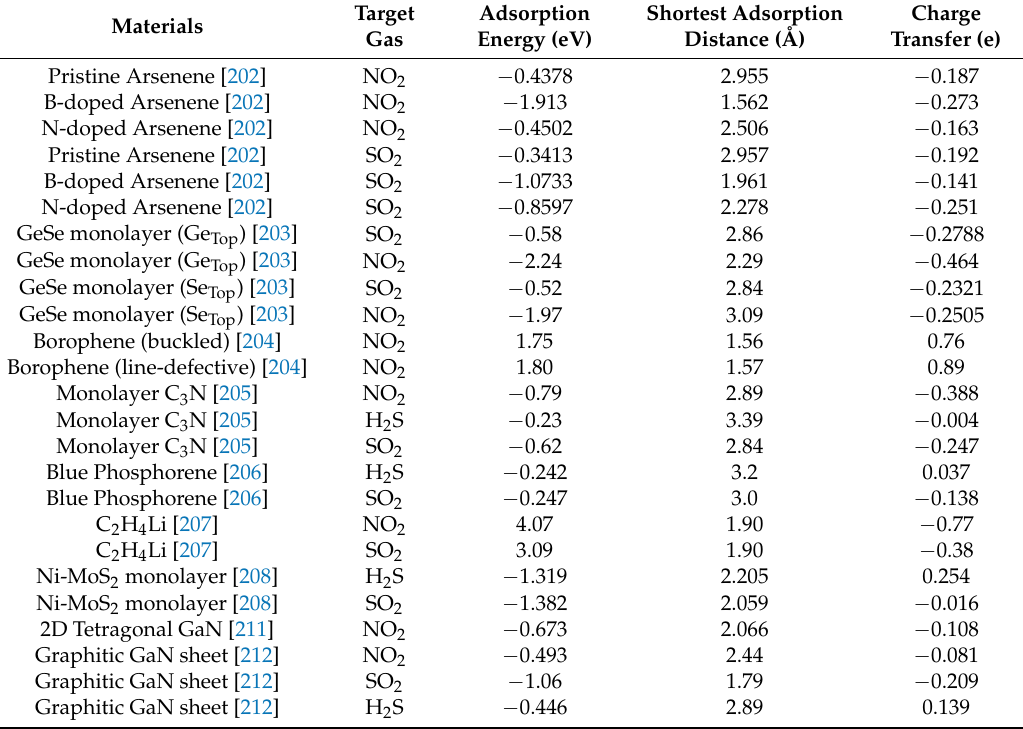
Table 4. The adsorption energy (eV), Shortest adsorption distance (Å) and charge transfer (e) between NO 2, SO 2, H 2 S and various sensing materials at the most stable adsorption configuration based on